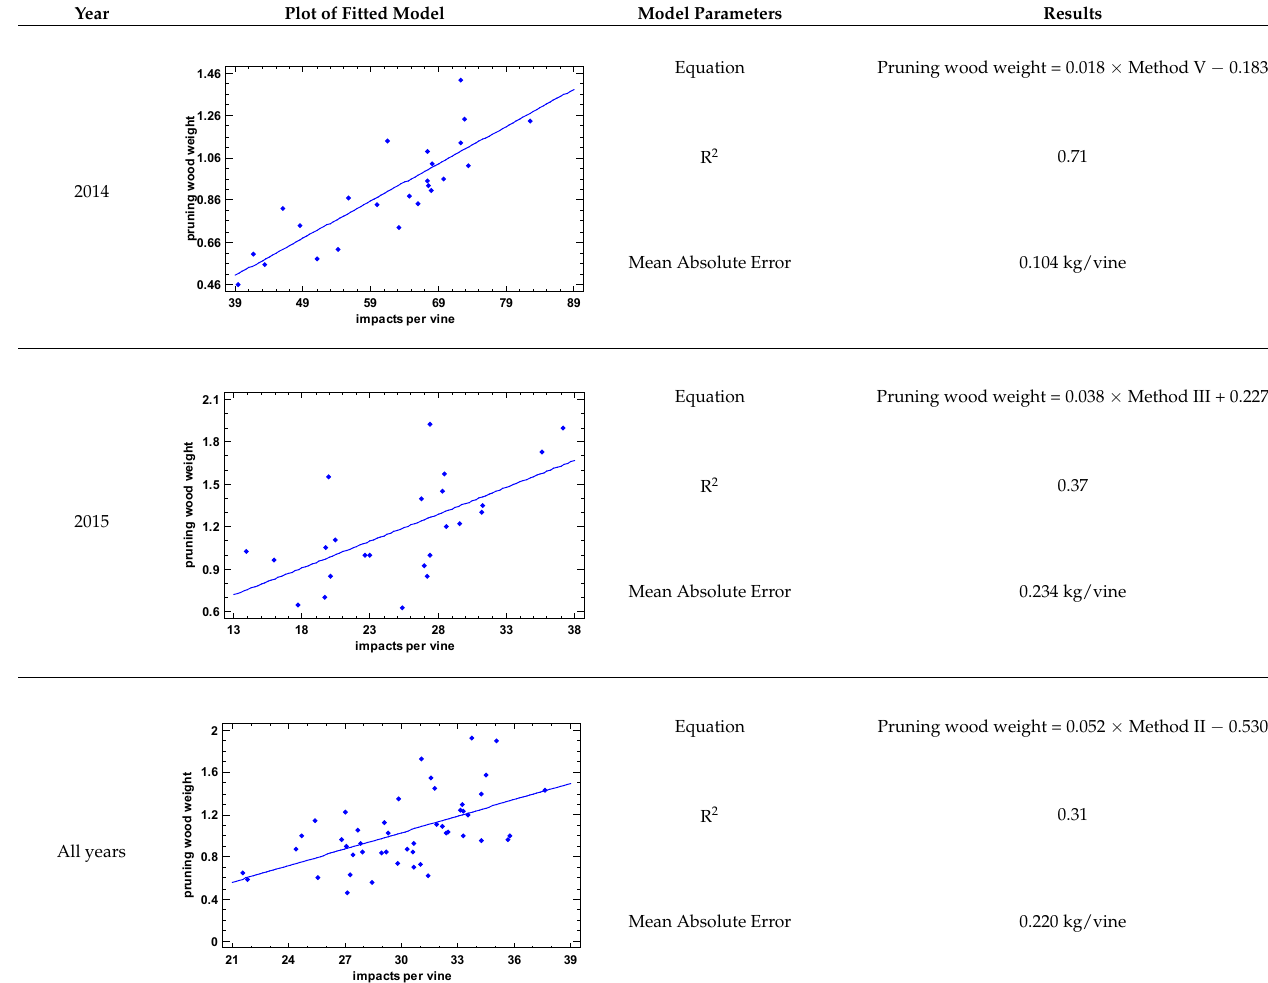
Table 4. Best fitted models for the estimation of pruning wood weight using a laser scanner on Sauvignon Blanc.